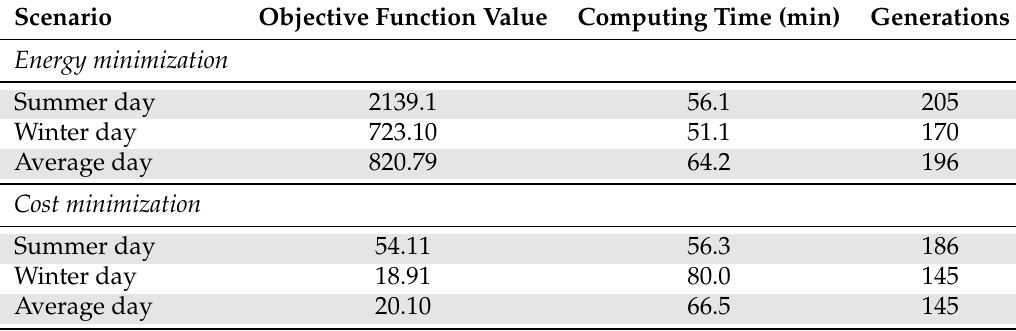
Table 8. GA optimization problem outputs.